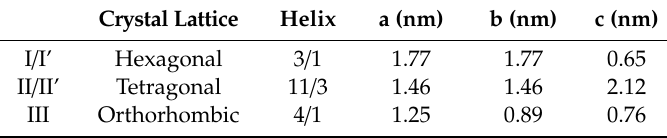
Table 1. Crystallographic data [6] and references